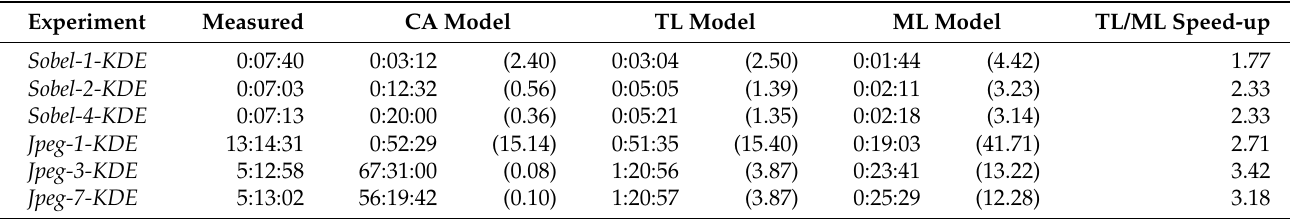
Table 3. Simulation time (HH:MM:SS) with Kernel Density Estimation computation model for 1,000,000 iterations. Experiment Measured CA Model TL Model ML Model TL/ML